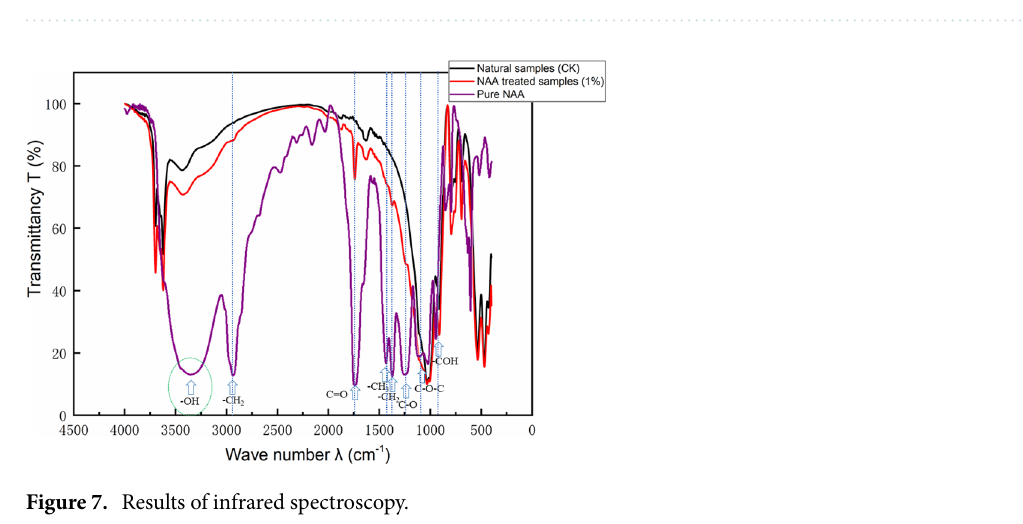
Figure 6. Shear strength under 50 kPa axial compression. ( a ) Under different curing ages, and ( b ) Under different NAA content.